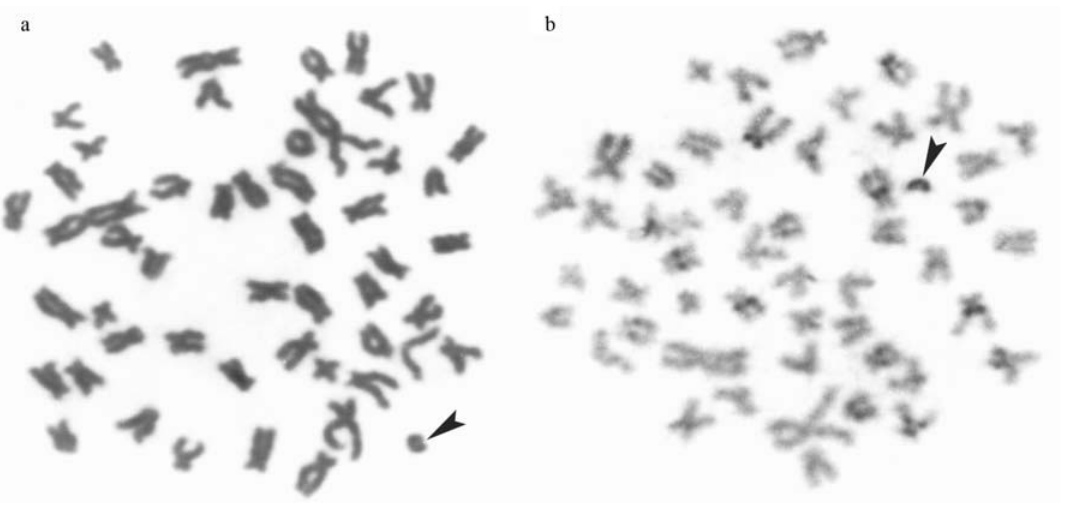
Figure 2 - Metaphases of Astyanax altiparanae from the Campo Novo River. Arrows indicate the supernumerary chromosome (conventional Giemsa staining) (a) and the heterochromatic supernumerary chromosome after C-banding